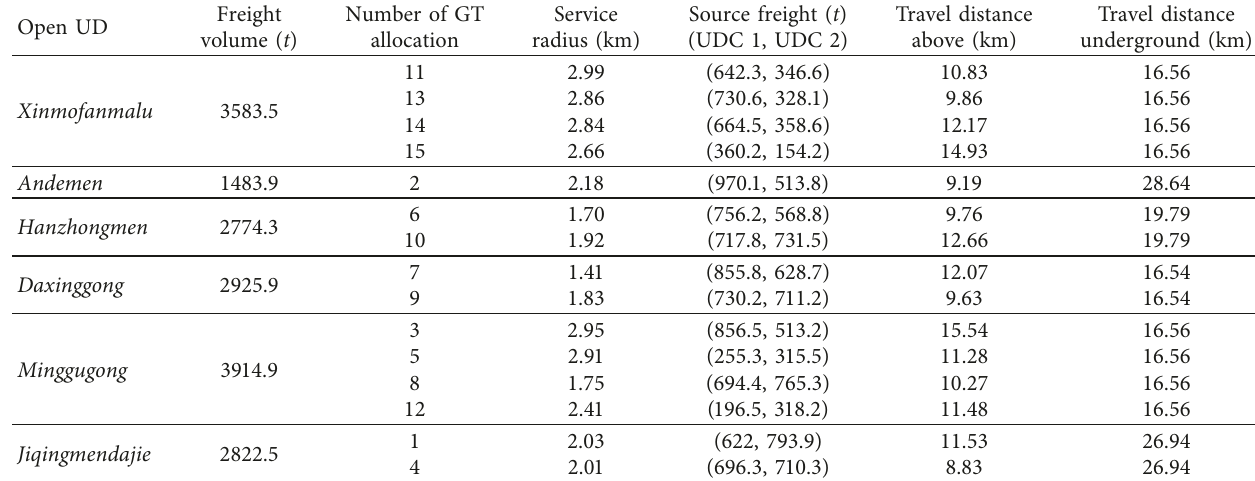
Table 2: Summary of optimal node information.